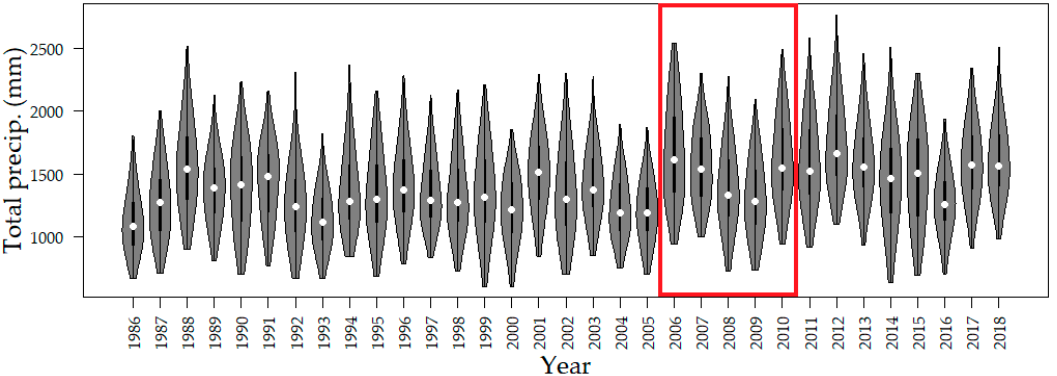
Figure 13. Violin plot of average total annual precipitation in the MEE. The red box highlights the period